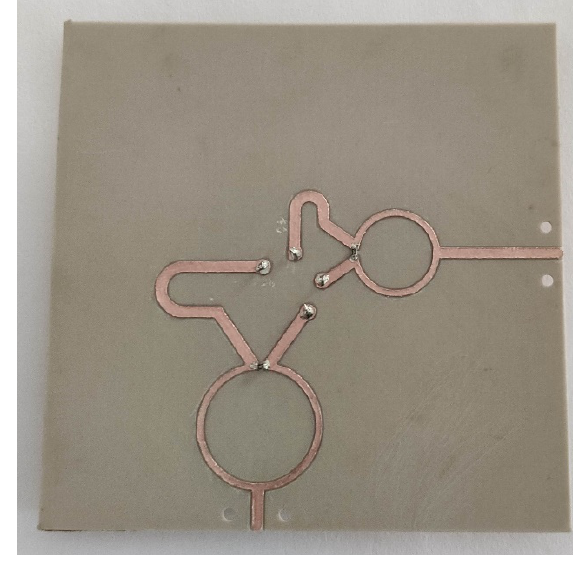
Figure 8. Fabricated antenna ( a ) top view; ( b ), bottom view.